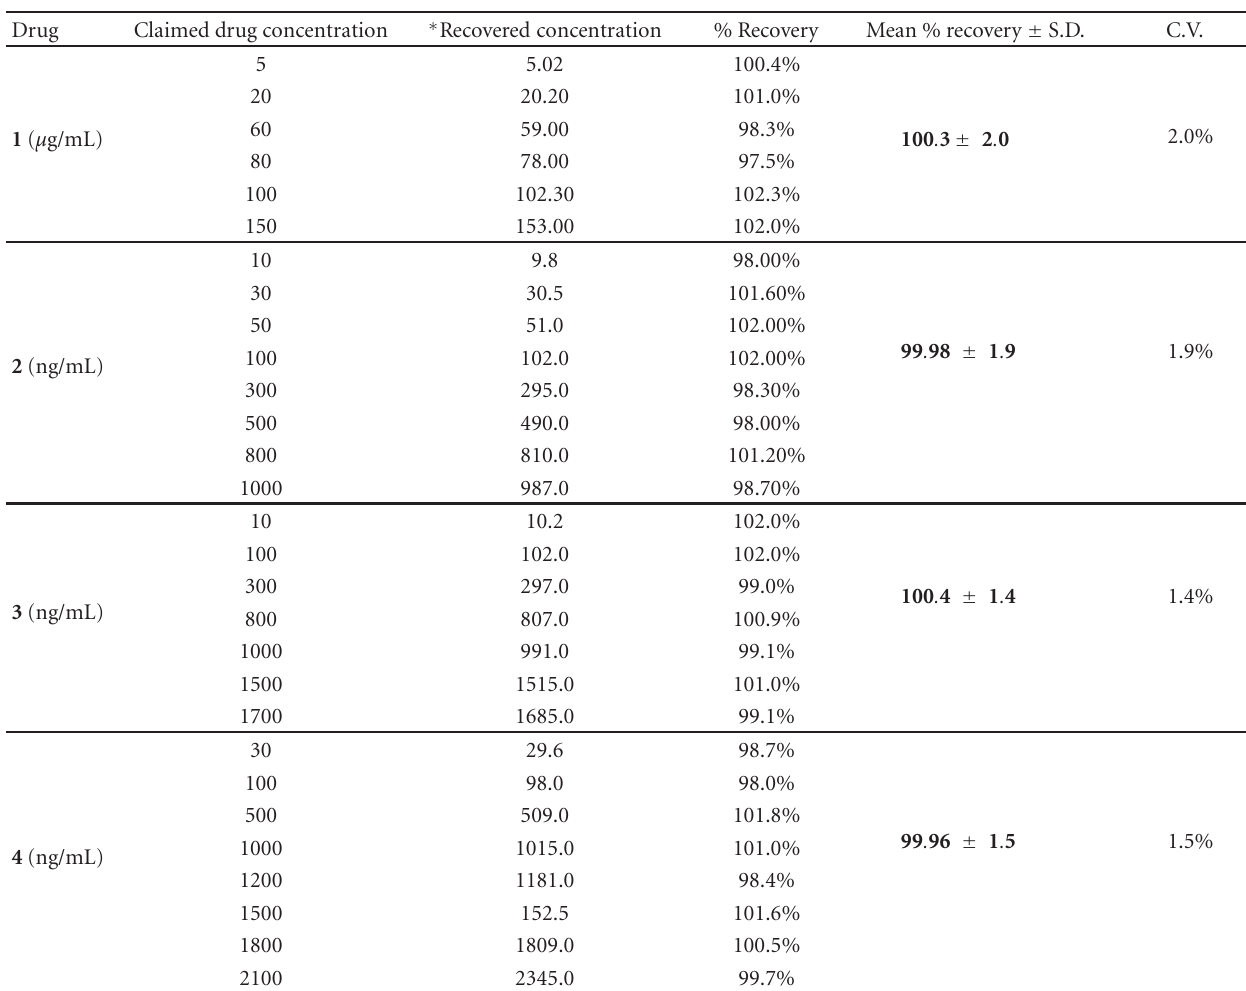
Table 4: Recovery data of 1–4 in spiked human plasma samples using the proposed method.